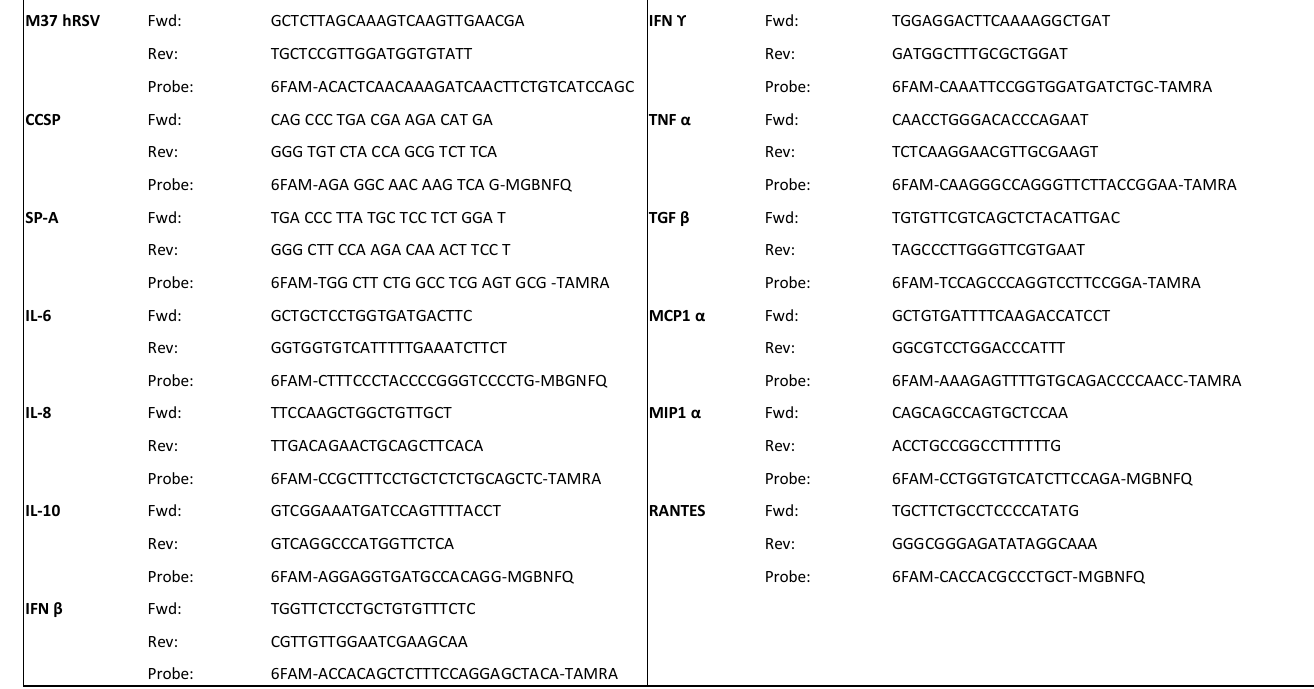
Table 1. Primer and probe sequences used for real-time qPCR, 5’ to